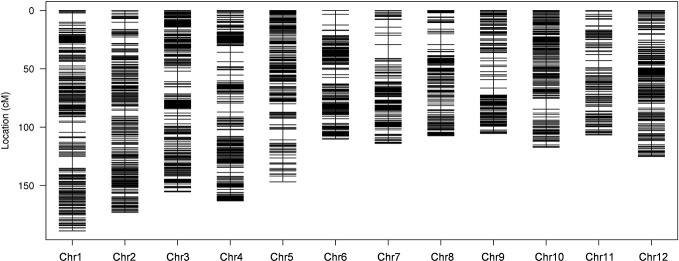
High-density genetic linkage map. The x-and y-axis represent chromosomes and genetic distance, respectively. Each black line indicates a specific length amplified fragment (SLAF) marker.